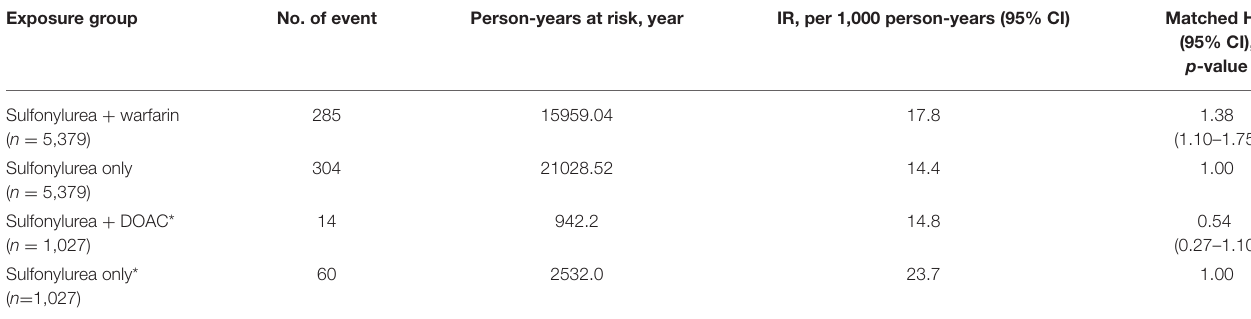
TABLE 3 | Number of events, incidence rates and HR, for risk of hypoglycemia for the matched cohort. Exposure